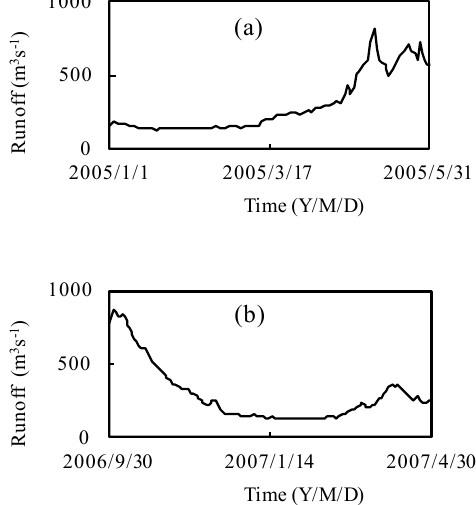
Figure 6. Runoff in the Yellow-River Source Region from 2005 to 2007. The study was carried out during the thawing (March to April) and freezing (October to March) periods.